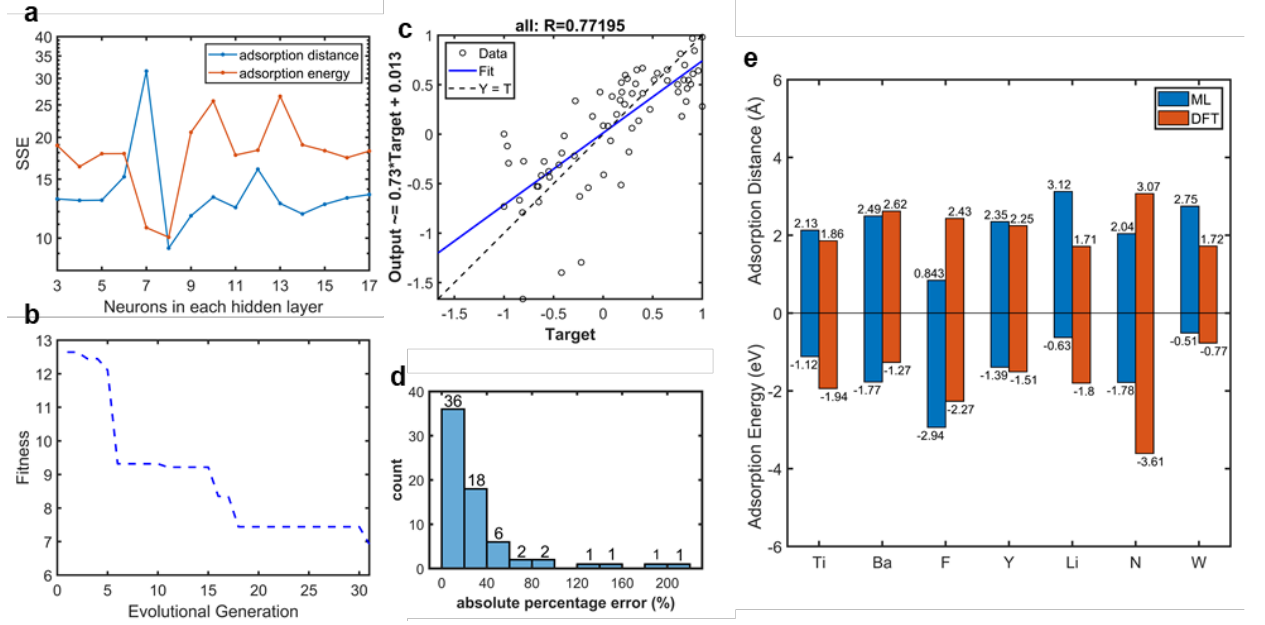
Figure 5. Network behaviors. ( a ) The sum of squared error (SSE) of the 5 × n × 2 network with different neurons in the hidden layer. ( b ) Fitness curve of our BPNN optimized by GA. ( c ) Regression scatter of the entire dataset (all the data normalized to − 1 to 1), whose correlation coefficient between outputs (BPNN predicted adsorption properties) and targets (DFT-calculated adsorption properties) was 0.77195. The regression equation is shown on y axis. ( d ) Distribution of absolute percentage error of our BPNN with the whole dataset. ( e ) Comparation of adsorption properties (including adsorption energy and distance) of testing adatoms on graphene calculated by DFT (red bars) and our ML model (blue bars).